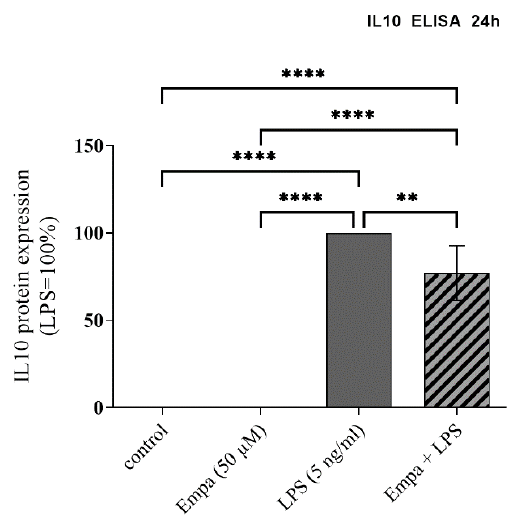
Figure 5. Protein expression of the anti-inflammatory cytokine IL10 was measured using ELISA after stimulation for 24 h. Empagliflozin significantly reduced the LPS-induced protein expression of IL10, while stimulation with empagliflozin alone showed no influence in comparison to the control (asterisks indicate all significant differences; ** p ≤ 0.01, **** p ≤ 0.0001; one-way ANOVA, followed by Tukey test; F-value = 218.5; n = 5).